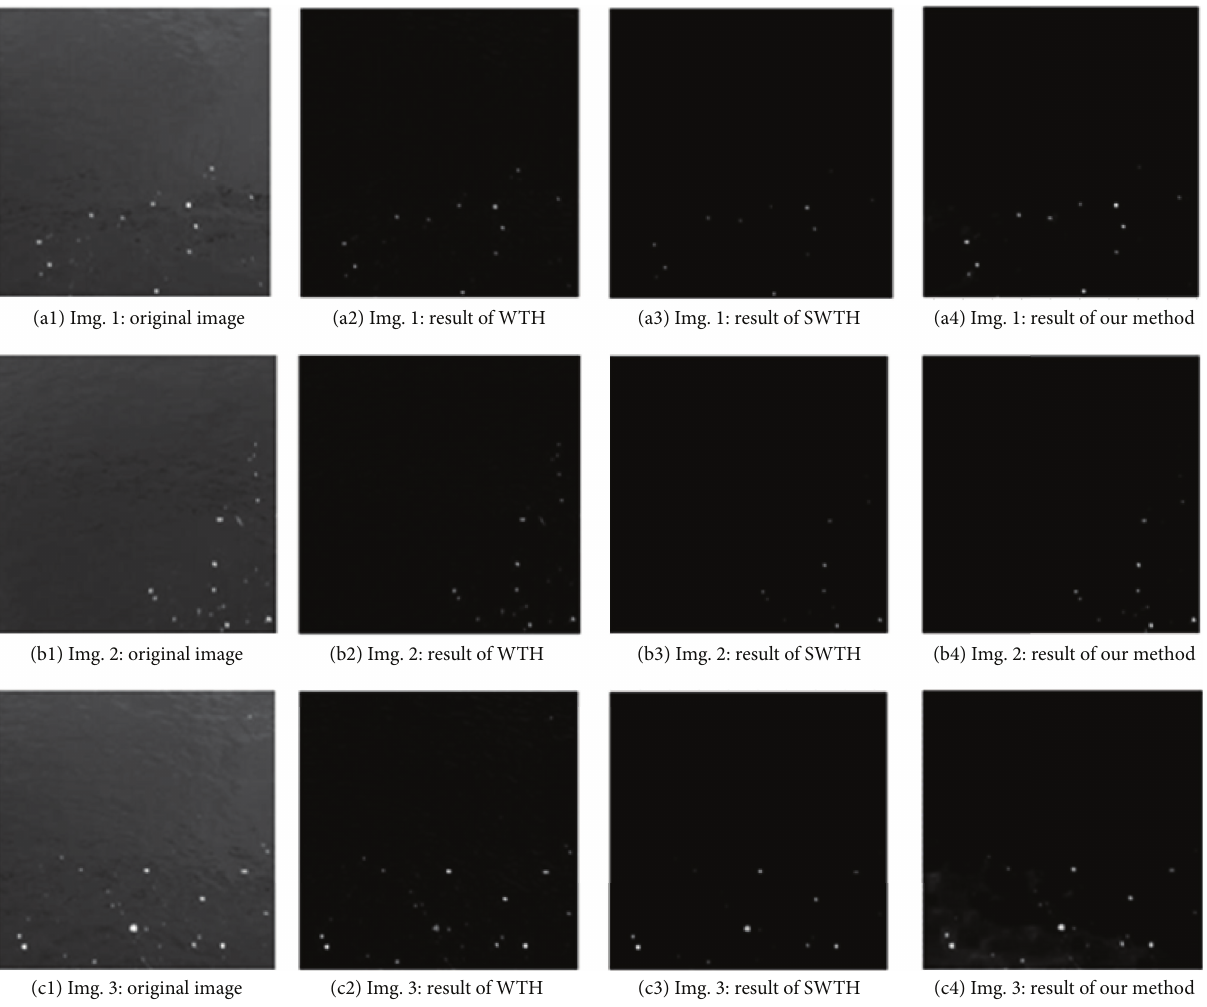
Figure 7: Comparison of three